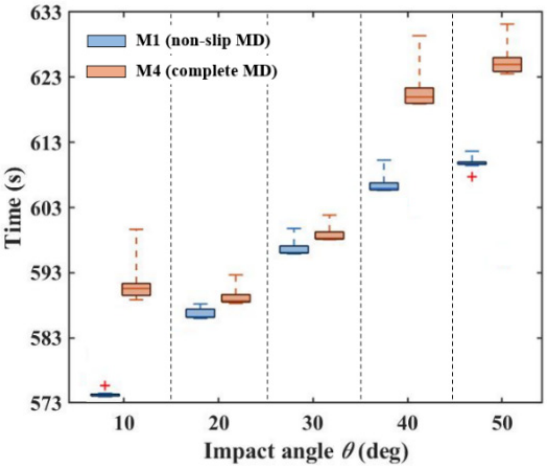
Figure 7. Comparison of the CPU calculation times of M1 and M4.